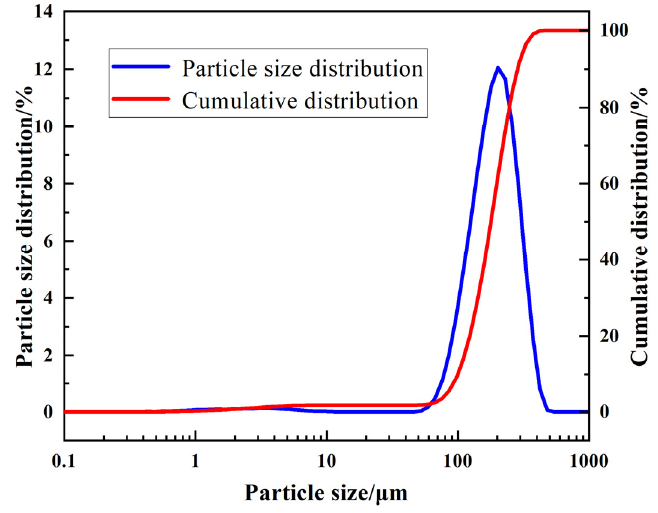
Figure 11. Particle size distribution curves of Xiaoluan River sediment. Table 3. Chemical composition of the Xiaoluan River sediment (%).